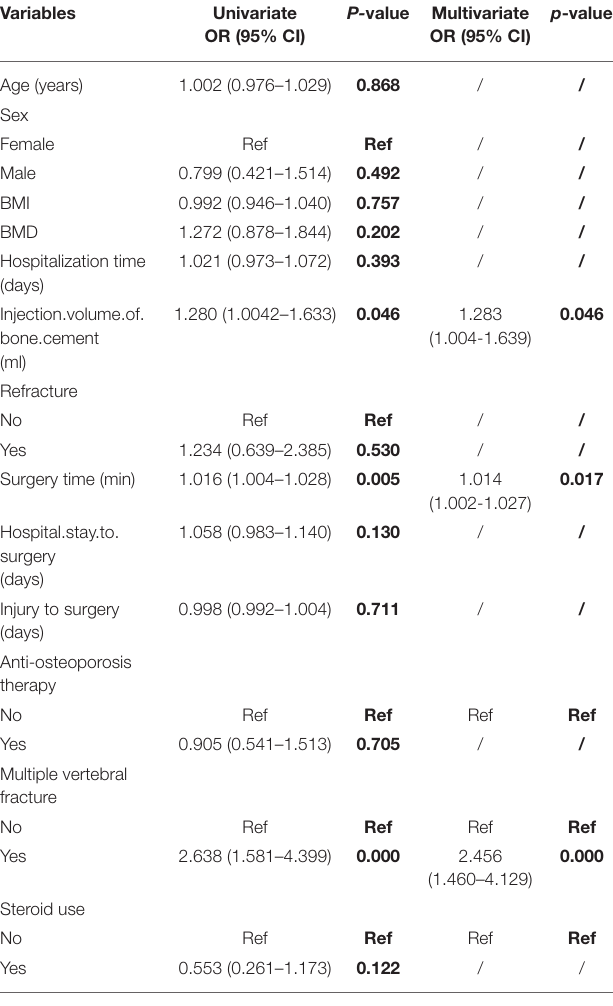
TABLE 2 | Univariate and multivariate logistic regression of bone cement leakage.